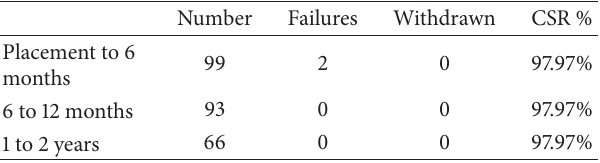
Table 3: Life table of cumulative survival rate for